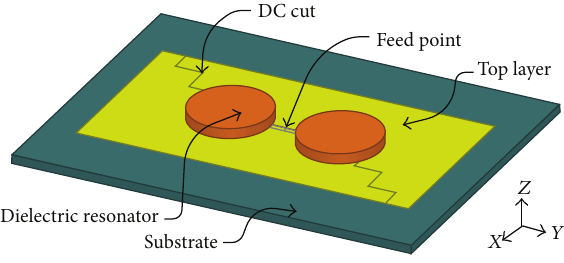
Figure 1: 3D model of proposed CDRA structure.